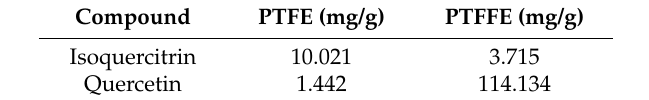
Table 2. Contents of isoquercitrin and quercetin in PTFE and PTFFE.